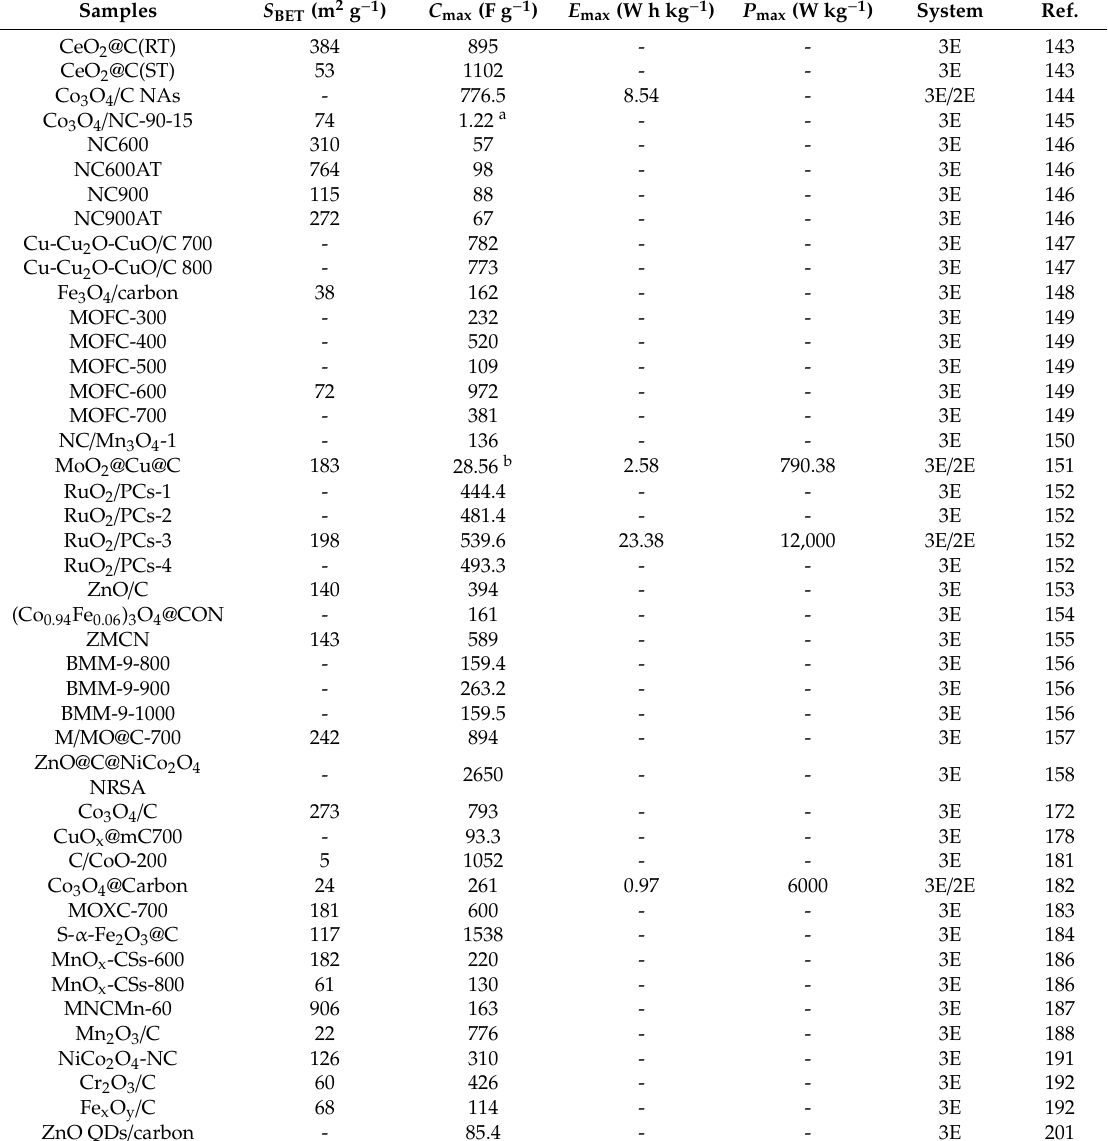
Table 9. The electrochemical capacitive properties of carbon / metal oxide composites.